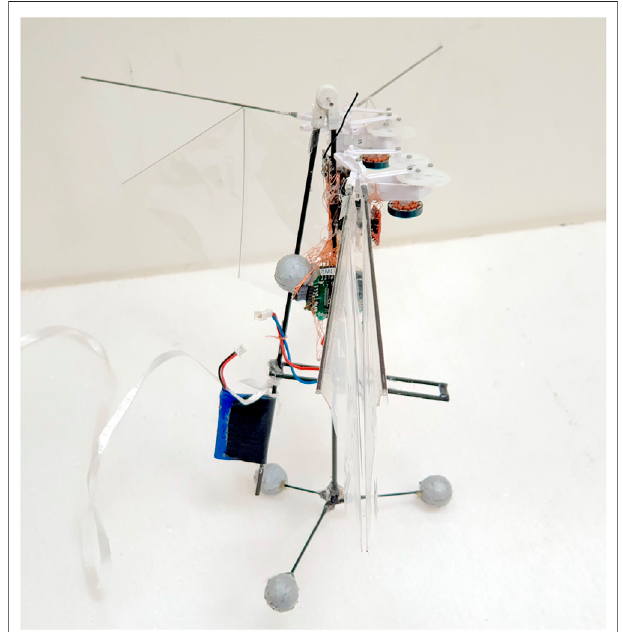
FIGURE5| Theasymmetric fl appingwingMAVusedintheexperiments, equipped with re fl ective markers of the motion tracking system and a new divider-like mass displacement